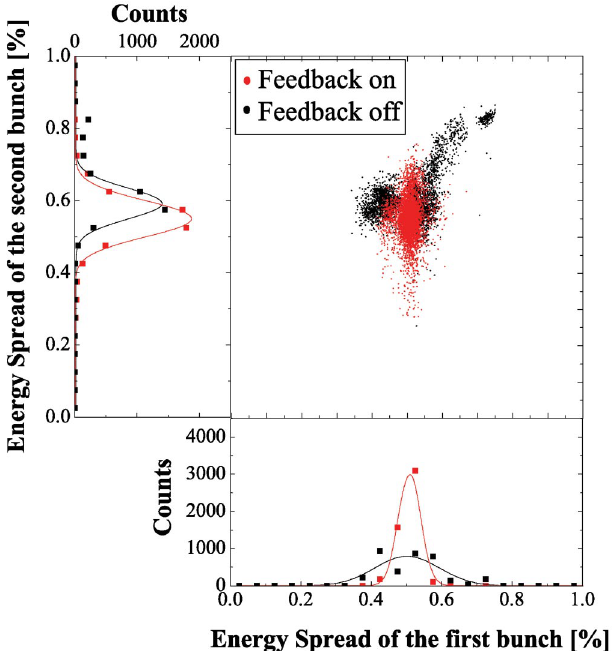
FIG. 8. (Color) Correlation scatter plot and the projected energy- spread distributions for the first and second bunches of the primary electron beam for positron production in the two-bunch acceleration mode measured at the 180 (cid:2) arc with the feedback control on and